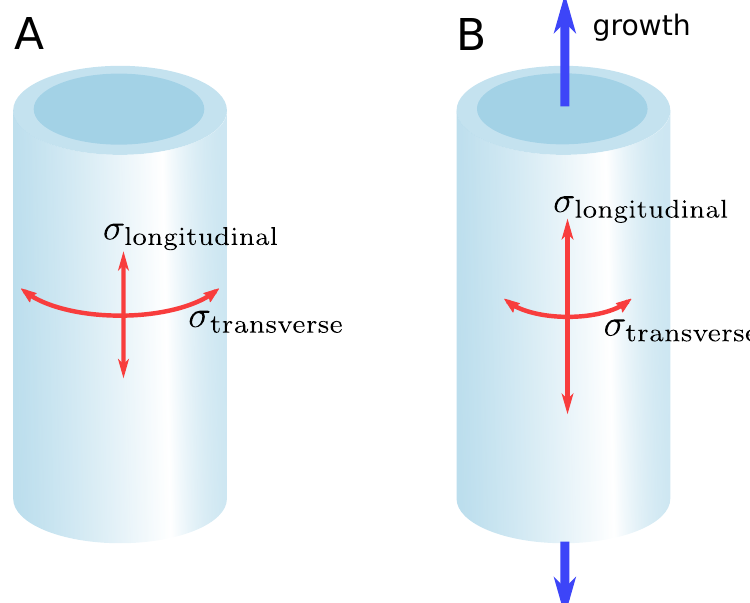
Figure 1. Shape-derived versus growth-derived stress pattern. ( A ) In the pressure vessel model, the stress pattern in the epidermis is determined by the shape of the organ. For a cylindrical organ, the transverse stress is higher than the longitudinal stress. ( B ) Differential growth between the inner tissue and the epidermis can override the stress pattern predicted by the pressure vessel model, leading to a longitudinal stress higher than the transverse